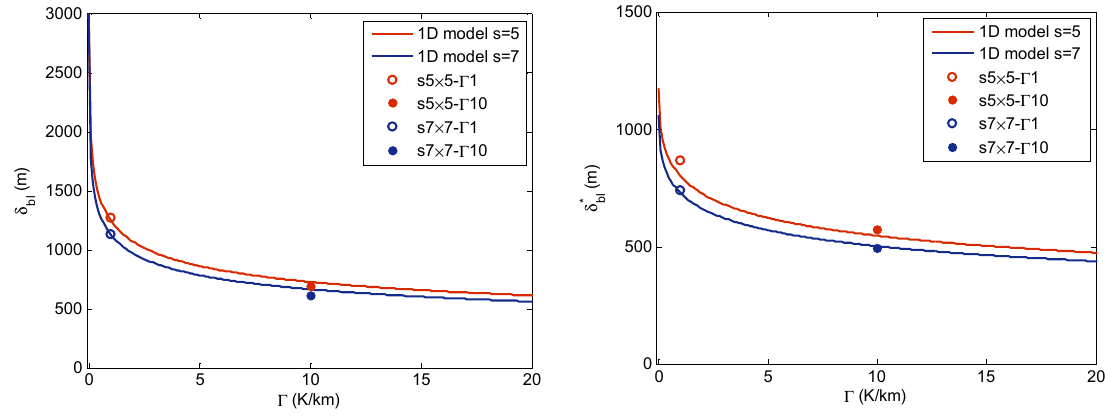
Figure 13. Influence of free-atmosphere stability on the height of the boundary